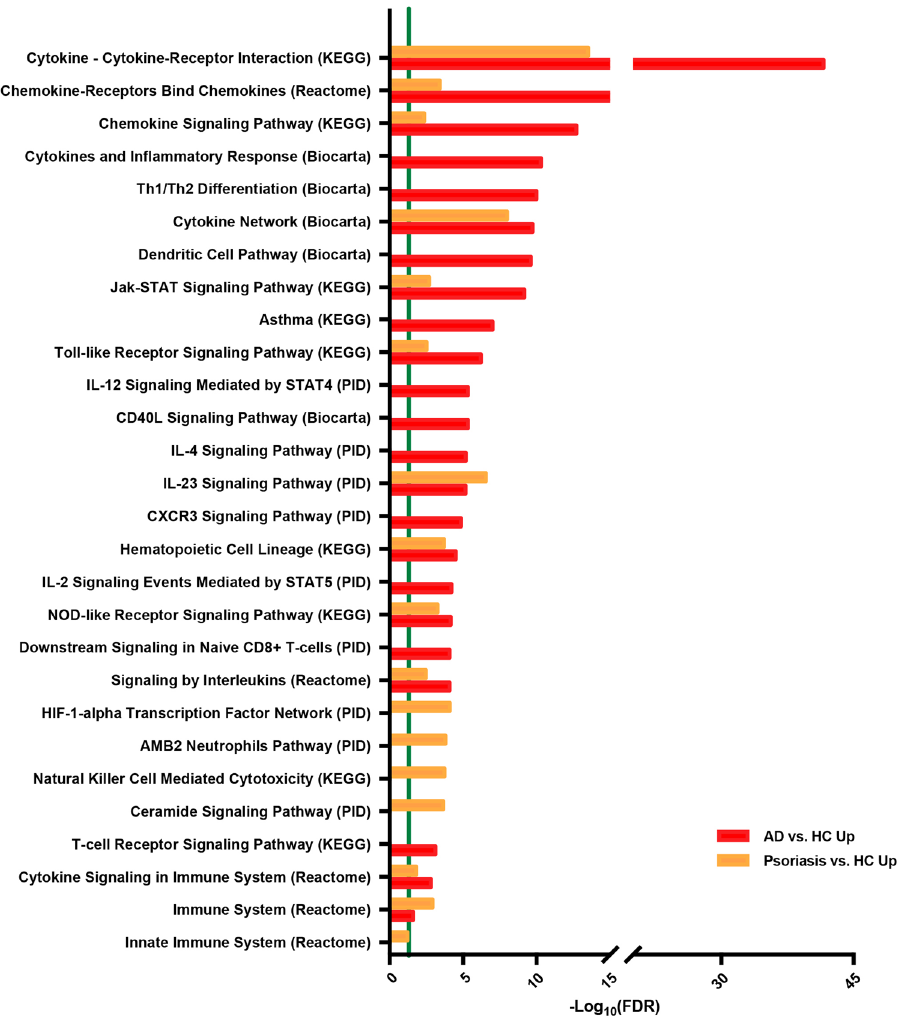
Figure 5. Pathway analysis. Selected pathways enriched in AD and psoriasis serum, compared to respective healthy controls; the green line indicates false discovery rate/FDR <